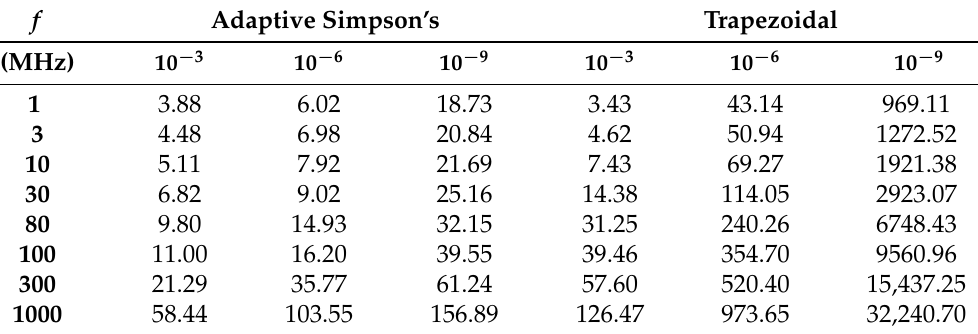
Table 1. Convergence time